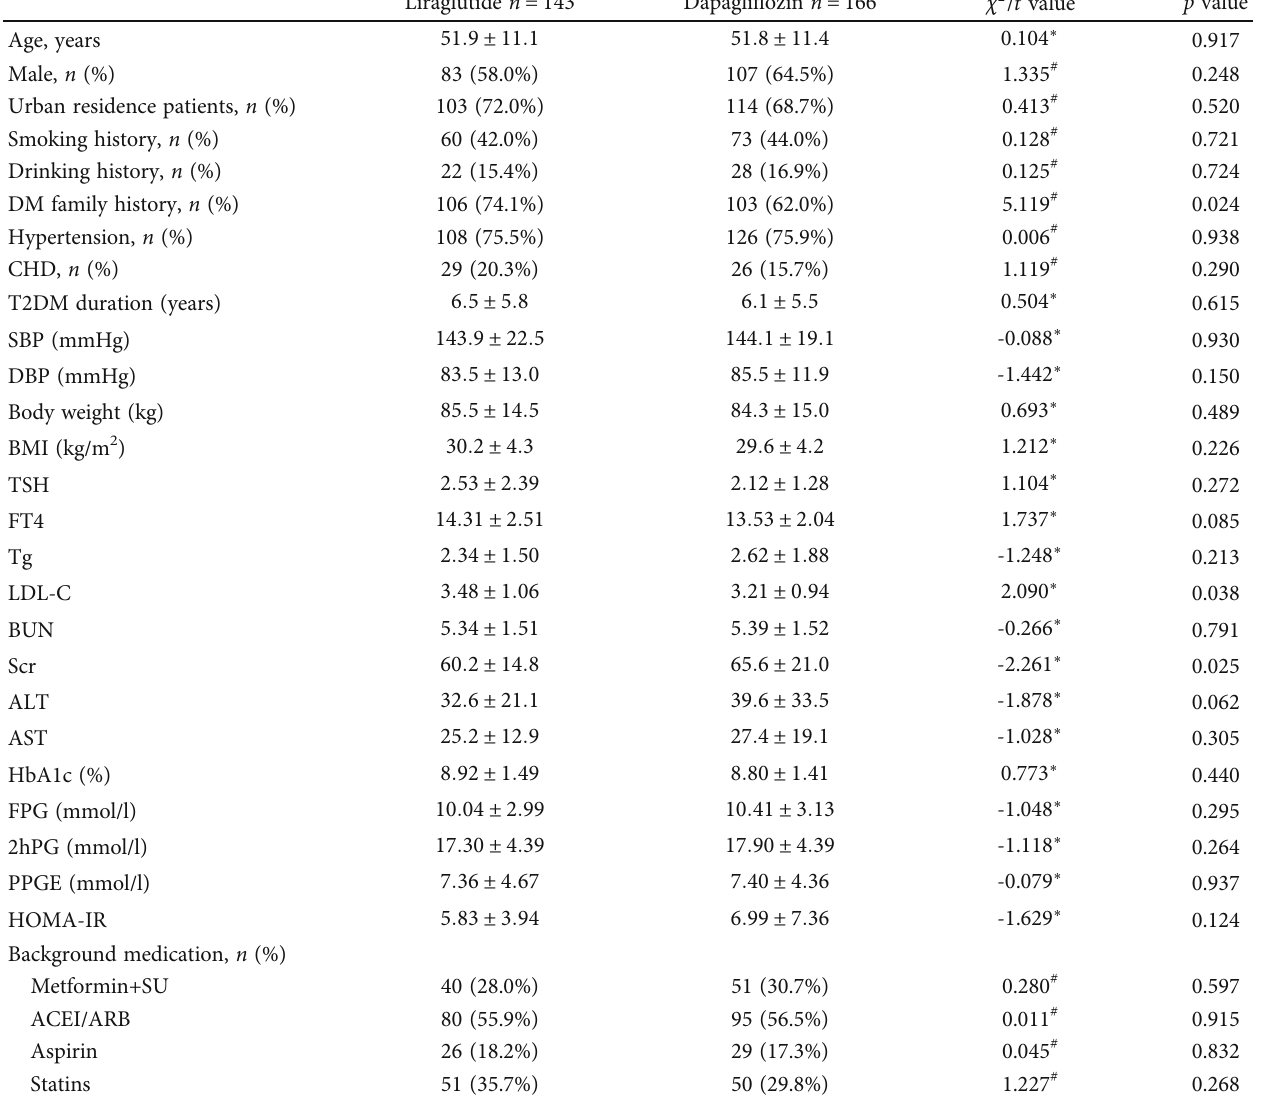
Table 1: Baseline demographic, anthropometric, and disease characteristics between the study groups. Liraglutide n =